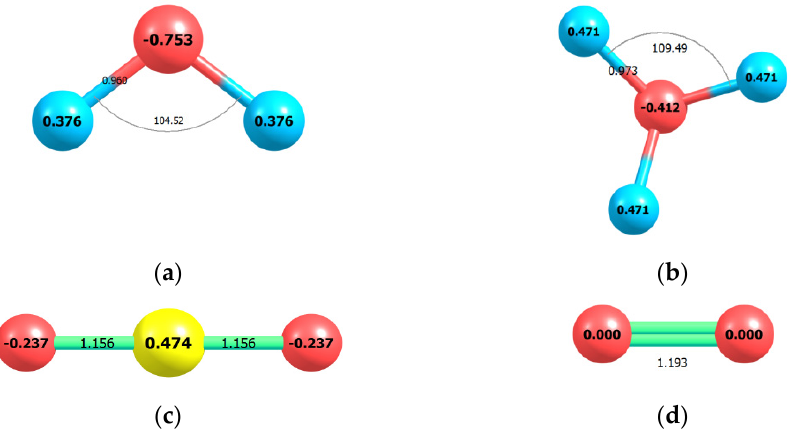
Figure A11. The calculated geometric and electronic structures: ( a ) H 2 O, Q = 0, M = 1, E 0 = − 2080.34 eV, G 0 = − 2080.25 eV; ( b ) H 3 O + , Q = 1, M = 1, E 0 = − 2091.54 eV, G 0 = − 2091.10 eV; ( c ) CO 2 , Q = 0, M = 1, E 0 = − 5132.52 eV, G 0 = − 5132.76 eV; ( d ) O 2 , Q = 0, M = 3, E 0 = − 4091.14 eV, G 0 = − 4091.58